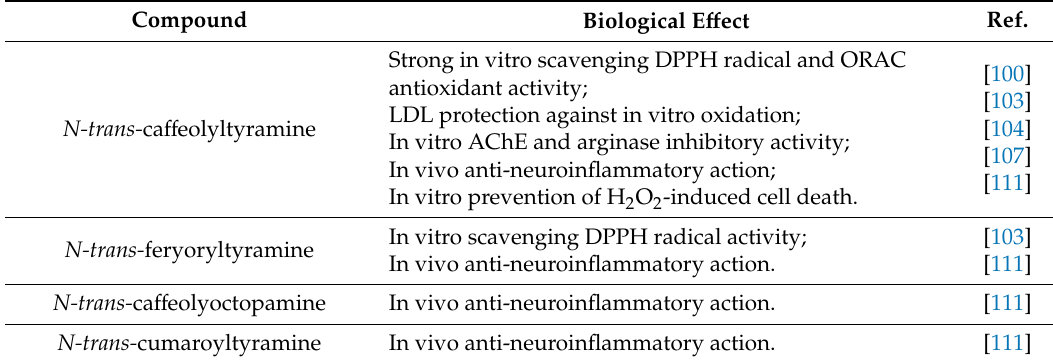
Table 10. Hempseed phenylpropionamides and their biological e ff